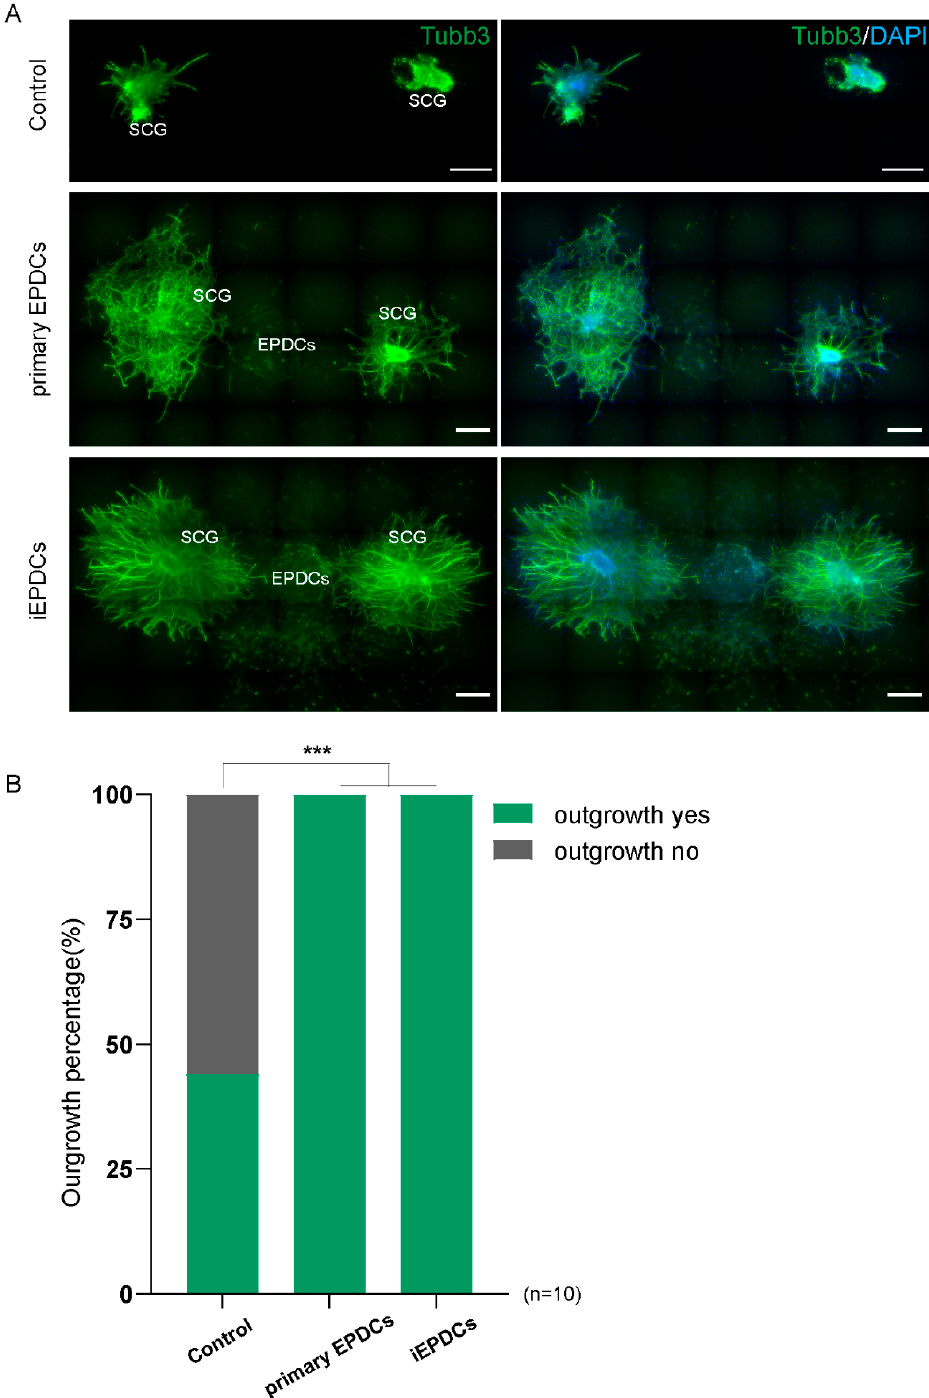
Figure 6. Mesenchymal iEPDCs promote neurite outgrowth of sympathetic ganglia . ( A ) . Representative immunofluorescence images (Tubb3 staining) of embryonic superior cervical ganglia (SCG) outgrowth after six-day culture alone or together with primary human EPDCs or iEPDCs in a 3D culture setup. Upper panel: No or hardly any neurite outgrowth is observed when SCG are cultured without EPDCs. Co-culture with primary human EPDCs (PD8, middle panel) or iEPDCs (PD30, lower panel) promotes neurite outgrowth from SCG. ( B ) . Quantification of the percentage of SCGs showing neurite outgrowth when cultured alone or co-cultured with primary human EPDCs or iEPDCs. Scale bar = 500 μ m. *** p < 0.001.